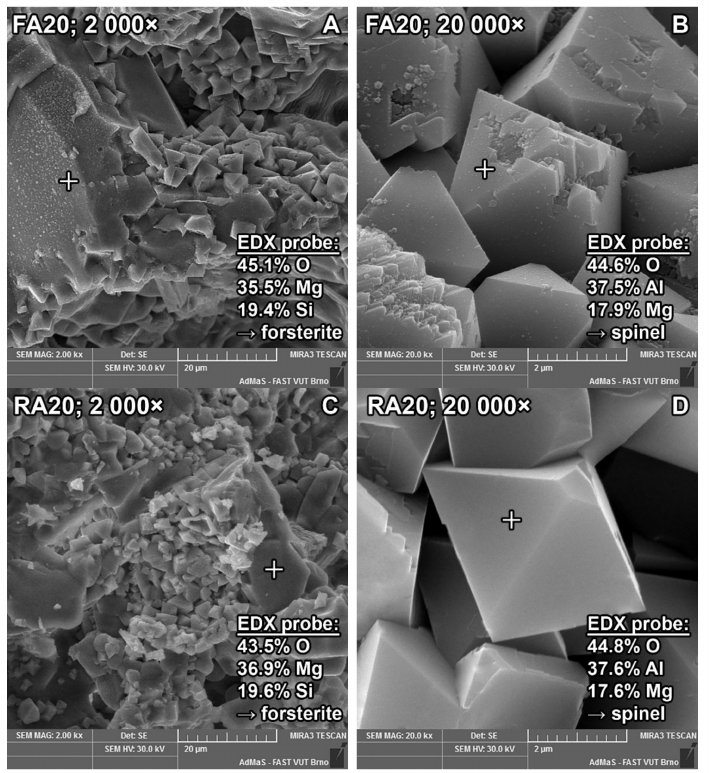
Figure 5. SEM images of mixtures ( A , B ) FA20 and ( C , D ) RA20 with magnifications of 2000 × (left) and 20,000 × (right) with EDX probe results.